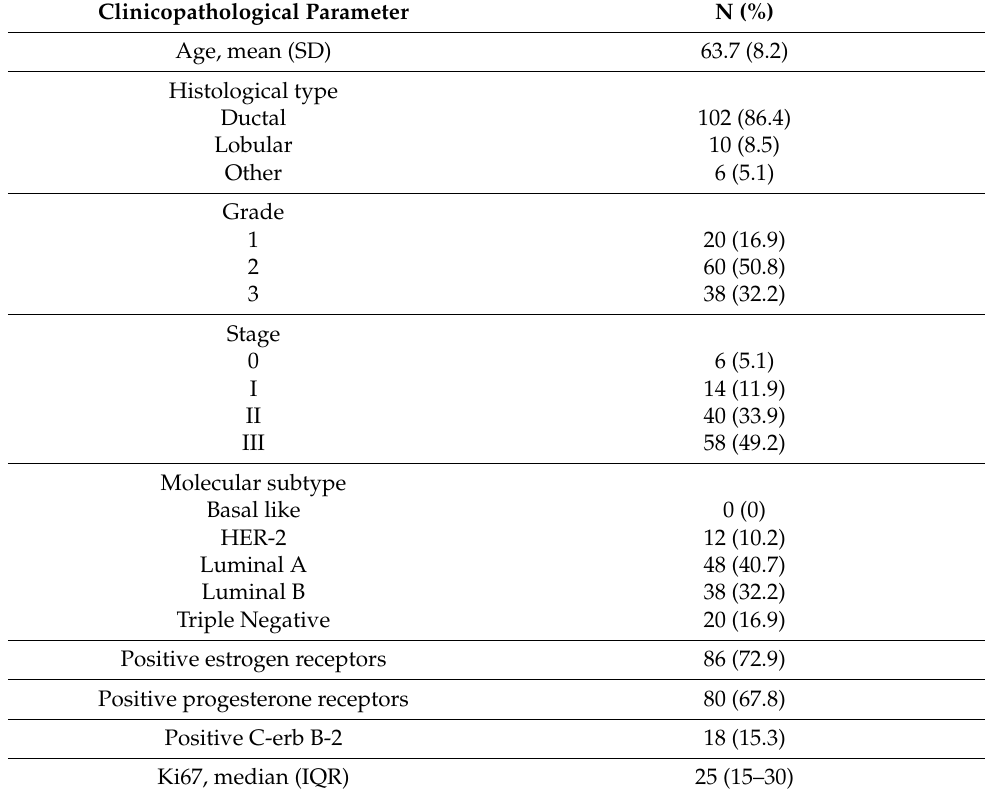
Table 1. Sample demographics and clinical characteristics.